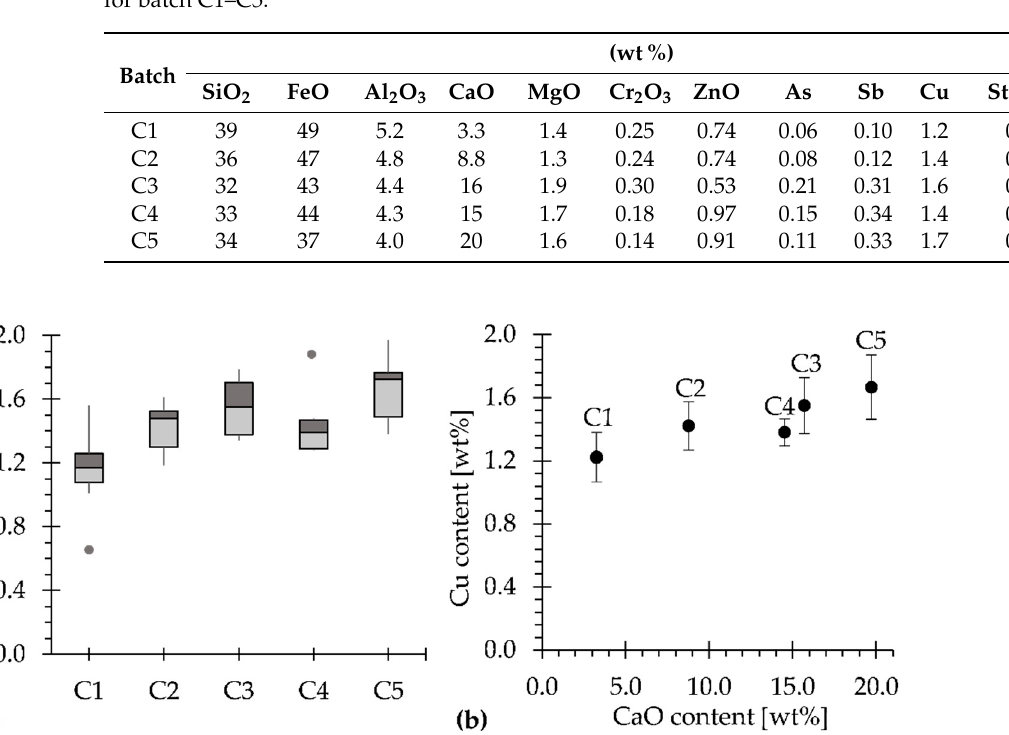
Table 2. Normalized compositions of the ingoing slag and the standard deviation of copper (st.d Cu) for batch C1–C5.